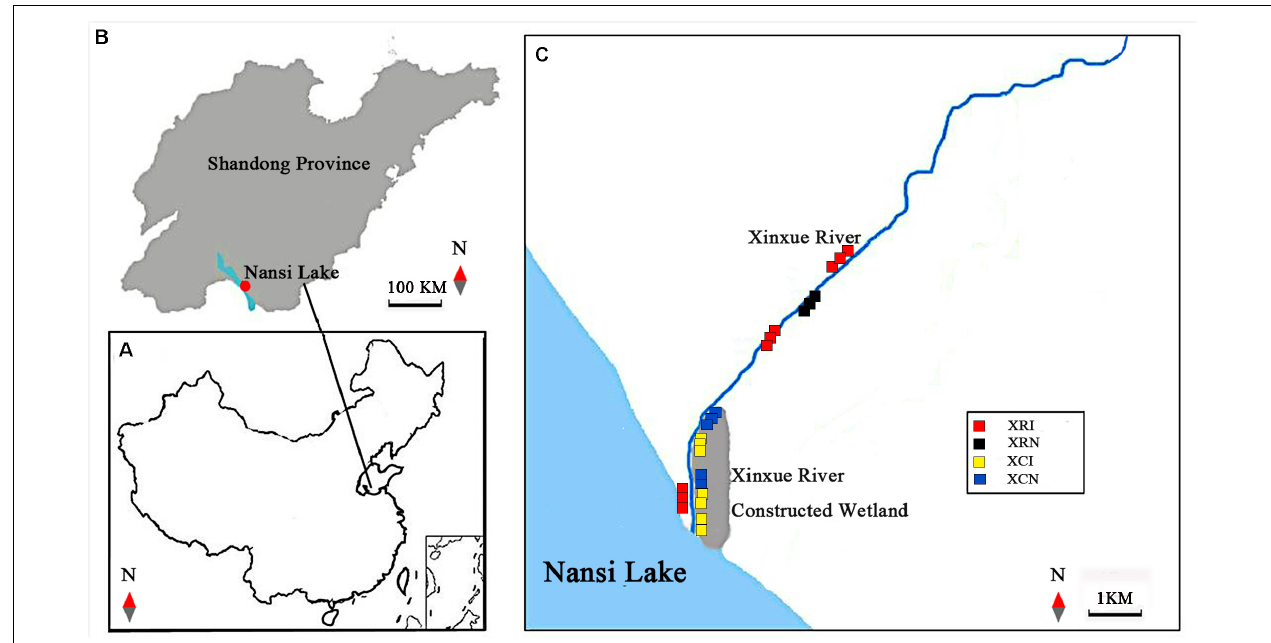
FIGURE 1 | Locations of Xinxue River and Xinxue River Constructed Wetland in Shandong Province and the distribution of invaded and non-invaded sites in the two types of wetlands. (A,B) are the locations of the Nansi Lake Basin in China and Shandong Province, respectively; (C) the distribution of invaded and non-invaded sites in Xinxue River and Xinxue River Constructed Wetland. XRI, Invaded sites in Xinxue River; XRN, Non-invaded sites in Xinxue River; XCI, Invaded sites in Xinxue River Constructed Wetland; XCN, Non-invaded sites in Xinxue River Constructed Wetland.